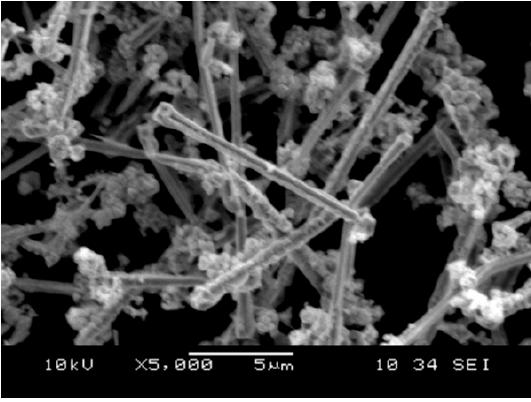
Figure 3. Morphology of the Cu fibers raw materials.